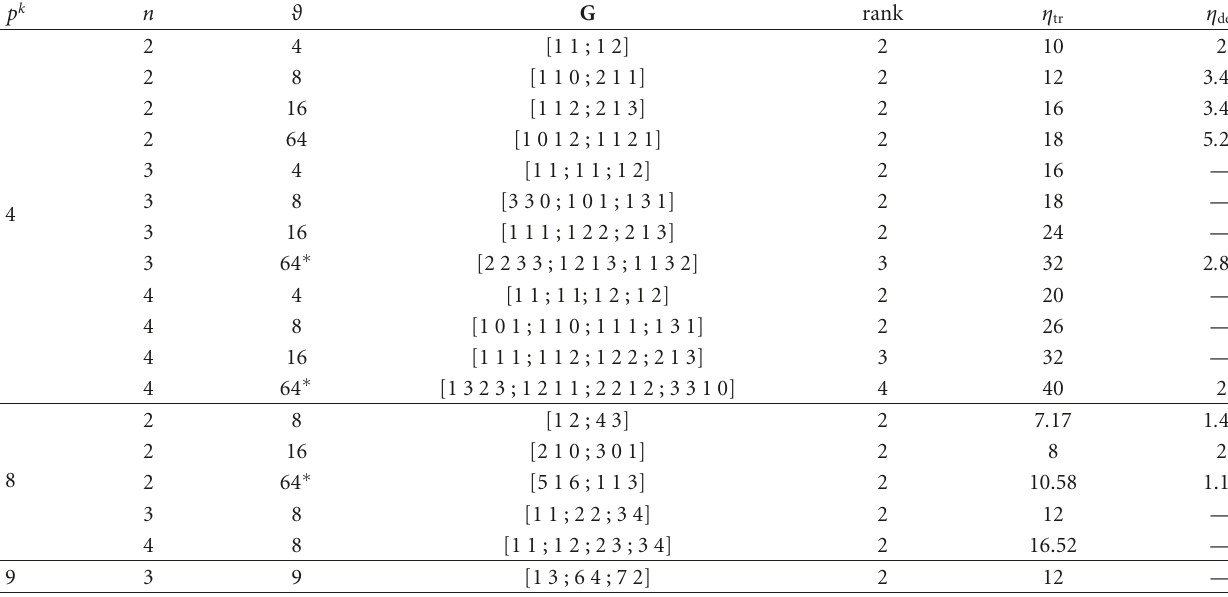
Table 2: New good STCCs over finite rings based on the trace criterion.